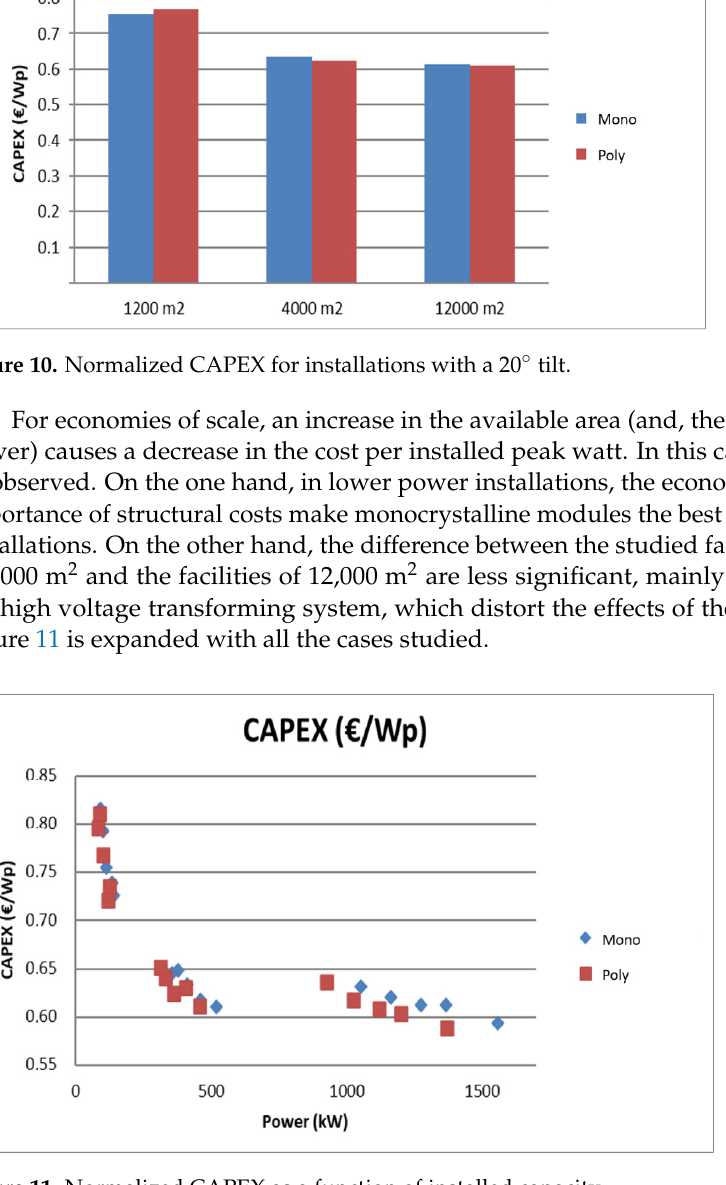
Table 5. Normalized costs for installations with 20° inclination.